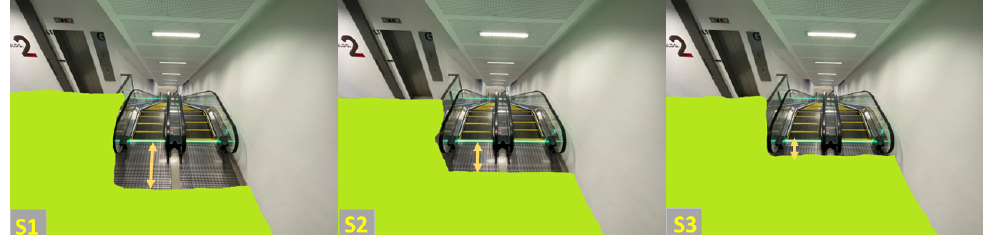
Figure 10. Generated track map after each trail from various starting points (S1 starting point 1, S2 starting point 2, and S3 starting point 3) near escalator of scenario-1 descending direction wherein the green pixels represents the robot-covered region and yellow arrow represents the distance between the covered region and escalator’s first